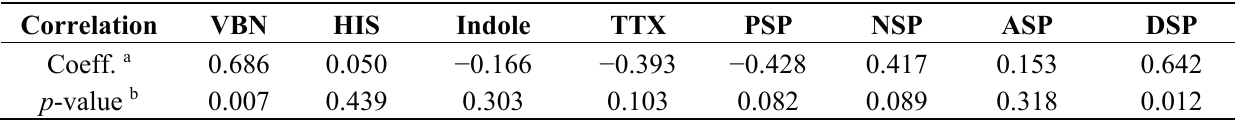
Table 5. The correlation of food-borne diarrhea and the monitoring index of live fresh aquatic products over 12